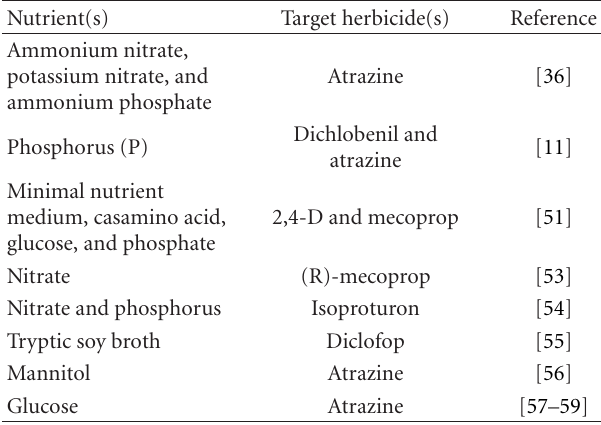
Table 2: List of nutrient supplements used for stimulating the biodegradation of herbicides in soil.